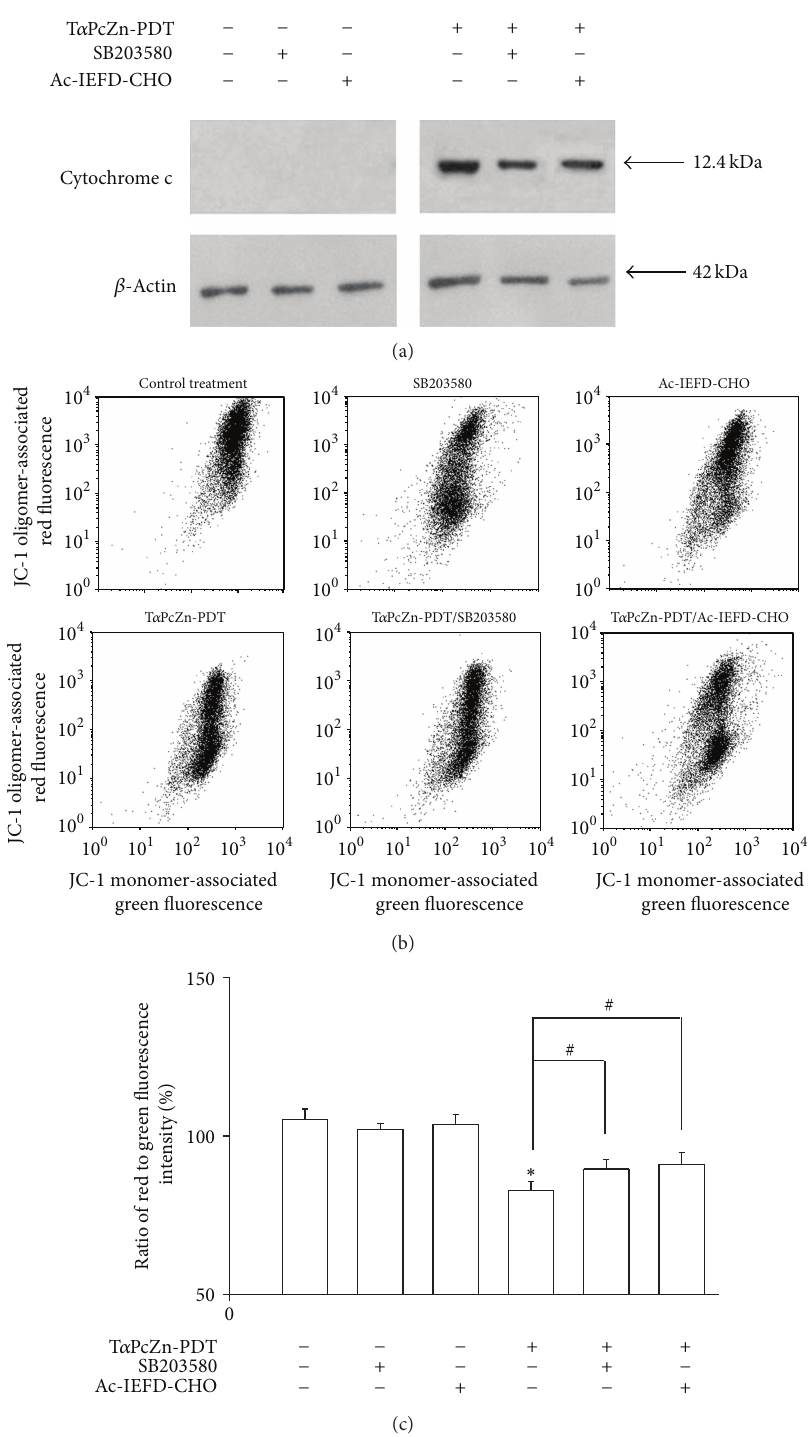
Figure 5: Effect of T 𝛼 PcZn-PDT on mitochondria of Bel-7402 cells in the absence or presence of SB203580 or Ac-IEFD-CHO. Bel-7402 cells were pretreated with T 𝛼 PcZn (54 𝜇 M) in the absence or presence of SB203580 (10 𝜇 M) or Ac-IEFD-CHO (10 𝜇 M) for 2.5 h, exposed to red-light irradiation (53.7 J/cm 2 ), and then incubated for 3h. Expression of Cytochrome c was analyzed by immunoblot assay (a), and mitochondria membrane potential (b) and ratio of red to green fluorescence intensity (c) in Bel-7402 cells were determined by JC-1 assay of flow cytometry, respectively. Values presented are representative of three independent experiments (means ± S.D.; ∗ 𝑃 < 0.05 , compared with control treatment; # 𝑃 < 0.05 , compared with T 𝛼 PcZn-PDT